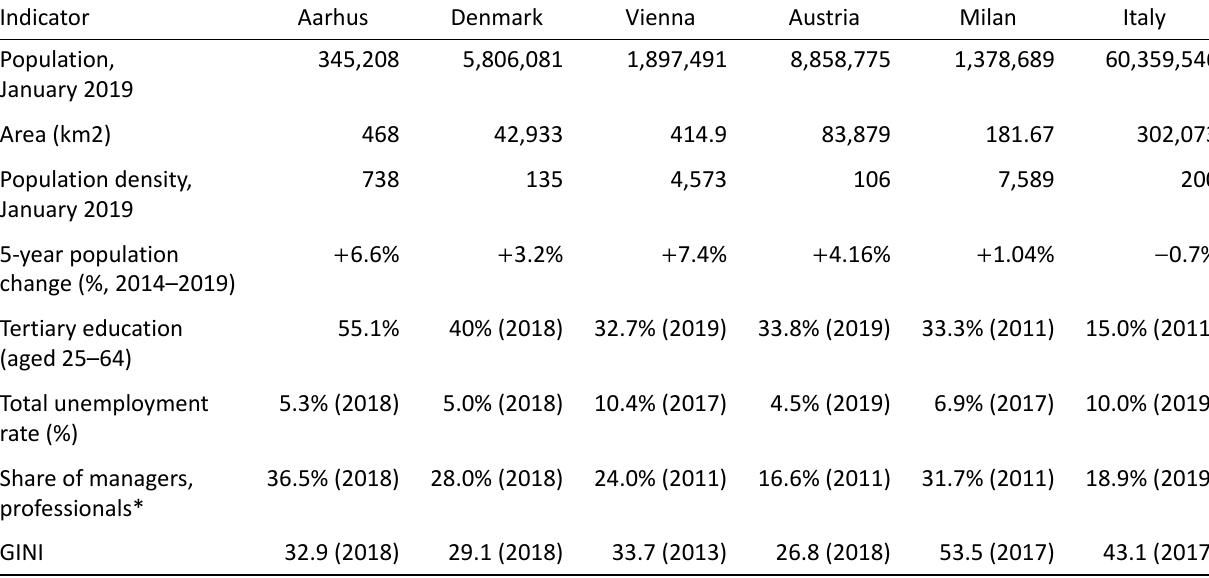
Table 1. Comparative data about the cities considered.